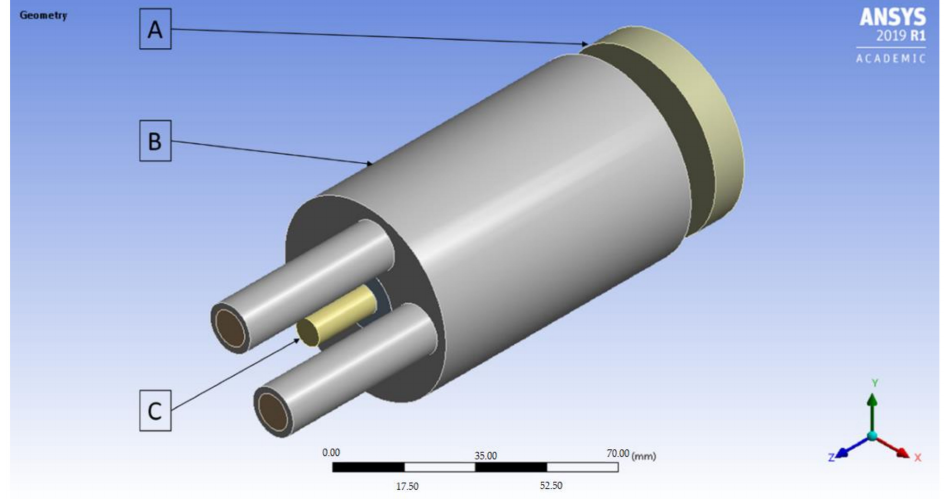
Figure 1. A general view of the implemented during the FEM simulations crystallization system;